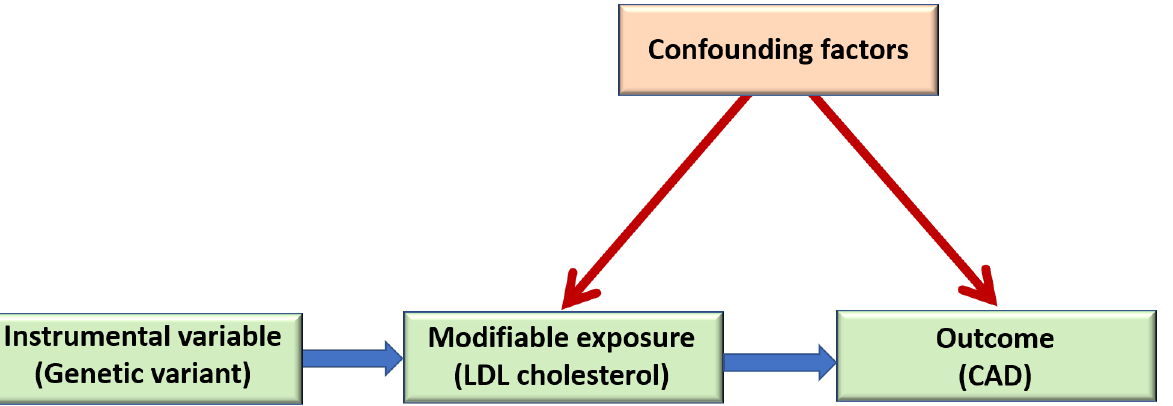
Figure 3. Mendelian randomization study. Genetic variants or polygenic risk scores are instrumental variables, for example, LDL cholesterol is a modifiable exposure, and coronary artery disease (CAD) is an outcome.